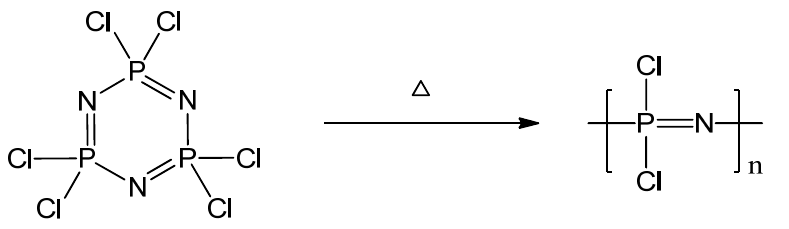
Figure 4. The living cationic polymerization route to